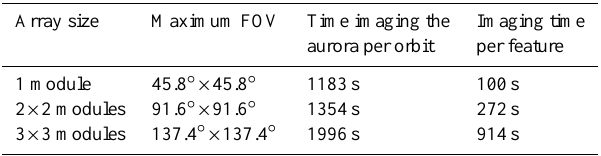
Fig. 9 . Contour plots of the mean gain over the detector active area. Left: image acquired with Fig. 9. Contour plots of the mean gain over the detector active area. the detector tilted by 13° so that the effective pore bias angle at the centre of the image is 0°. Left: image acquired with the detector tilted by 13 ◦ so that the ef- Right: image acquired with the detector at normal incidence (i.e. MCP pores angled at 13° to fective pore bias angle at the centre of the image is 0 ◦ . Right: image the source direction), showing improved gain in the centre of the active area. acquired with the detector at normal incidence (i.e. MCP pores an- gled at 13 ◦ to the source direction), showing improved gain in the centre of the active area.